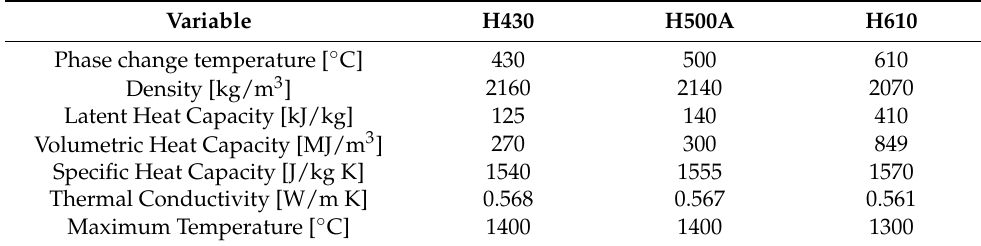
Table 2. PCM materials and their properties used in the